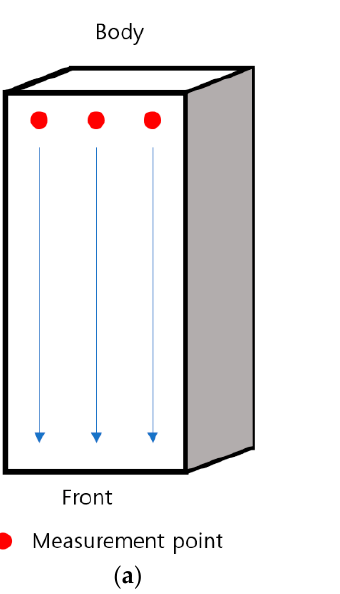
Figure 2. Electric vehicle charger measurement location: ( a ) body; ( b ) cable and handle.